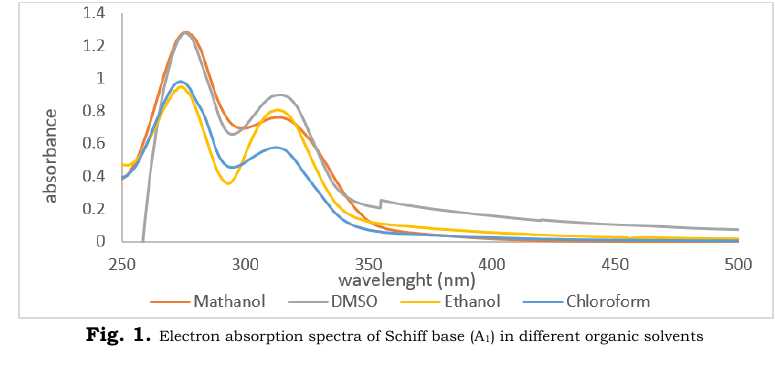
Fig. 1. Electron absorption spectra of Schiff base (A 1 ) in different organic solvents